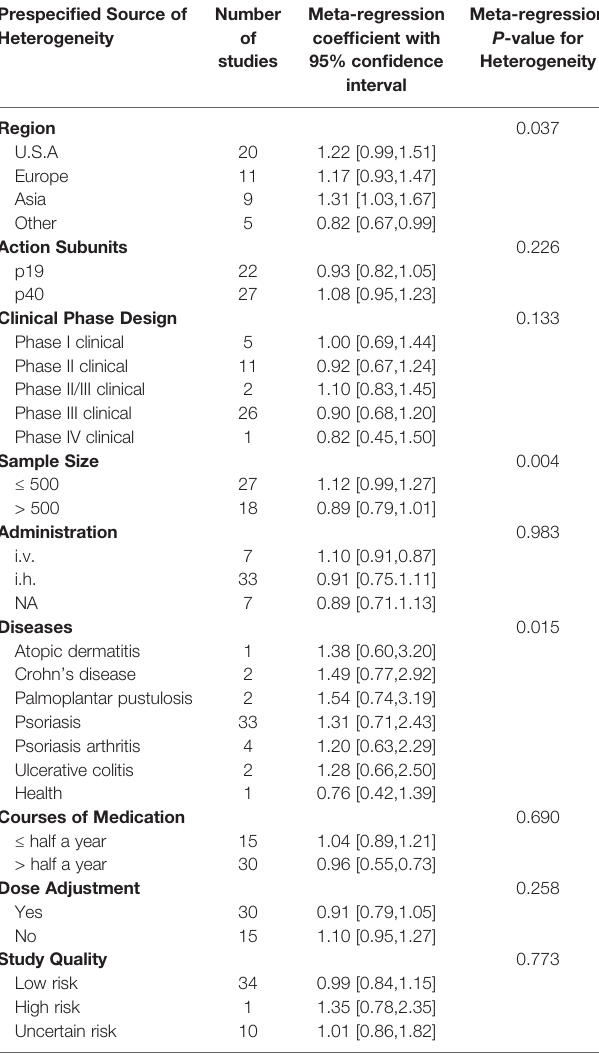
TABLE 3 | Potential prespeci fi ed sources of heterogeneity explored among the studies reporting AEs associated with anti-IL-23 agents. Prespeci fi ed Source of Heterogeneity